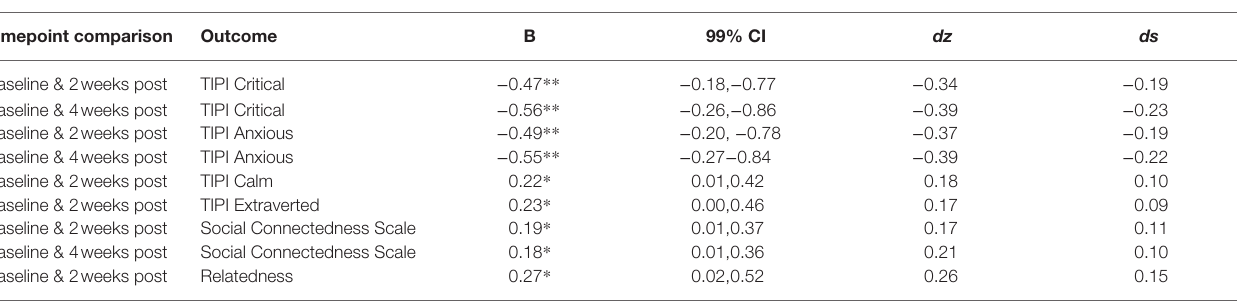
TABLE 3 | Examining significant main effects of